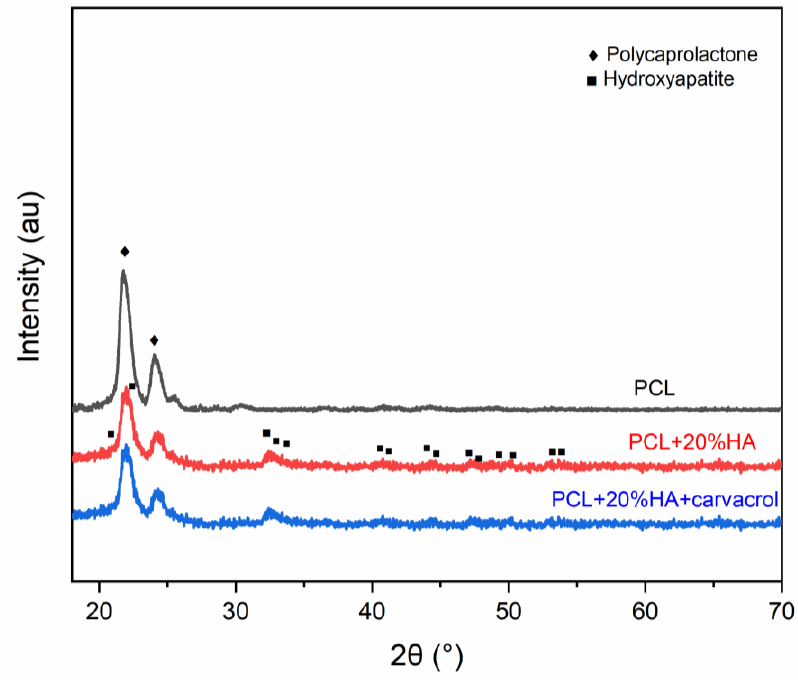
The presence of HA is also visible in XRD patterns of PCL foam and PCL scaffolds